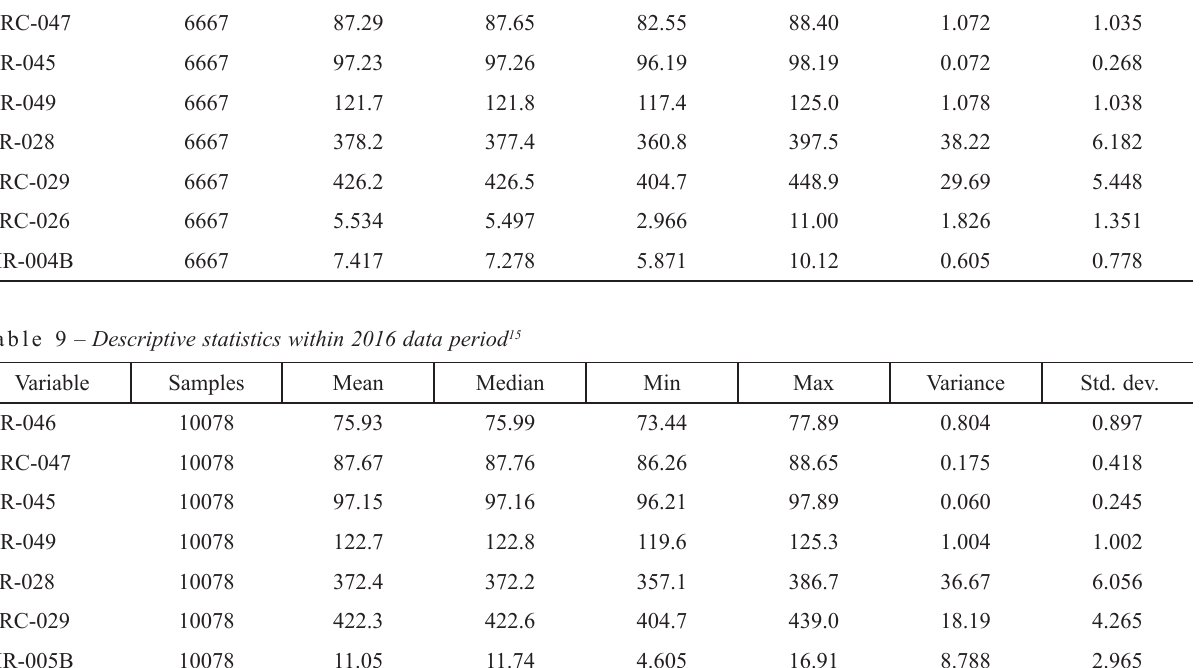
Variable Samples